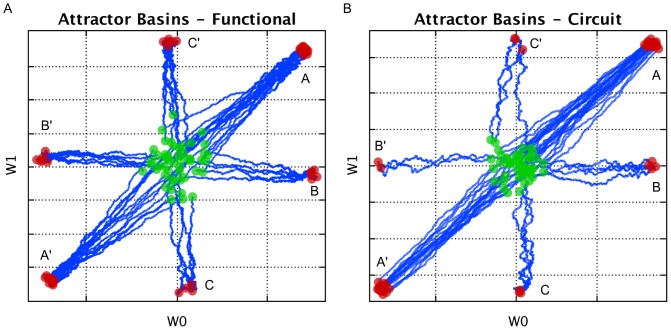
Attractor states of a two-input AHaH node under the three-pattern input.The AHaH rule naturally forms decision boundaries that maximize the margin between data distributions. Weight space plots show the initial weight coordinate (green circle), the final weight coordinate (red circle) and the path between (blue line). Evolution of weights from a random normal initialization to attractor basins can be clearly seen for both the functional model (A) and circuit model (B).